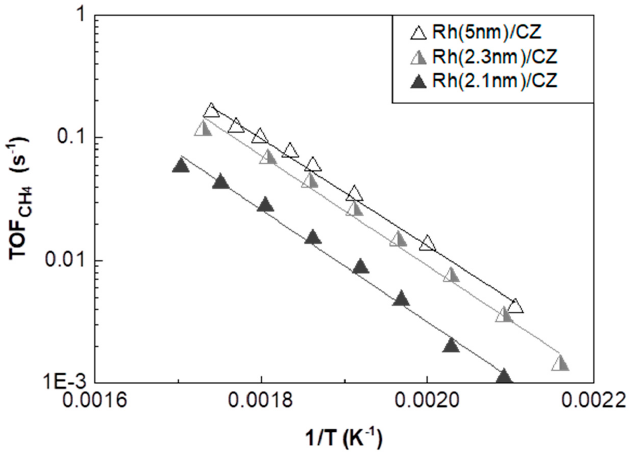
Figure 8. Arrhenius plots of the CH 4 formation turnover frequency ( TOF CH4 ) obtained for Rh / CZ catalysts with different mean Rh particle sizes. Experimental conditions as in Figure 7.